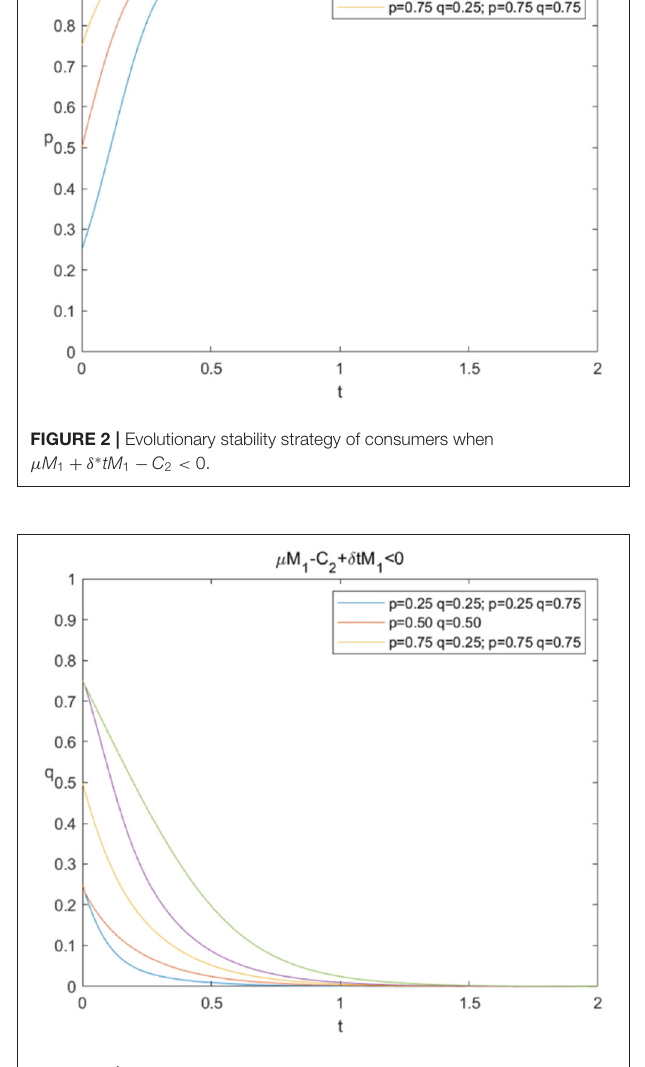
FIGURE 3 | Evolutionary stability strategy of e-commerce platforms when µ M 1 + δ ∗ tM 1 − C 2 <